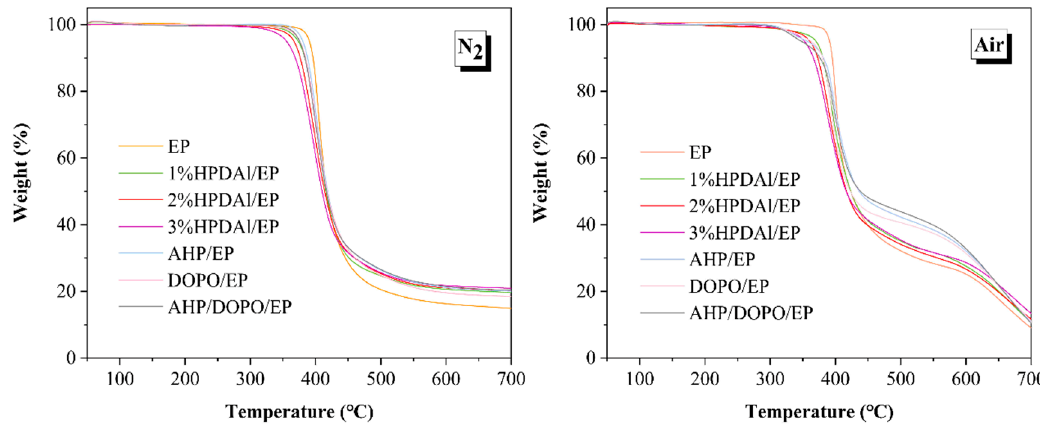
Figure 3. TGA curves of EP composites.